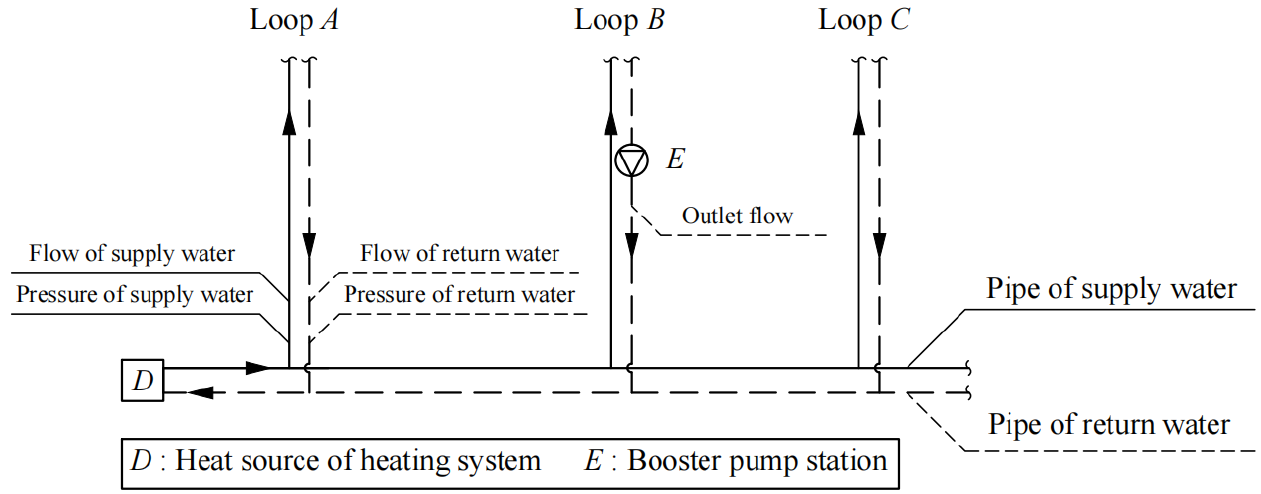
Figure 2. Schematic diagram of the heating network.